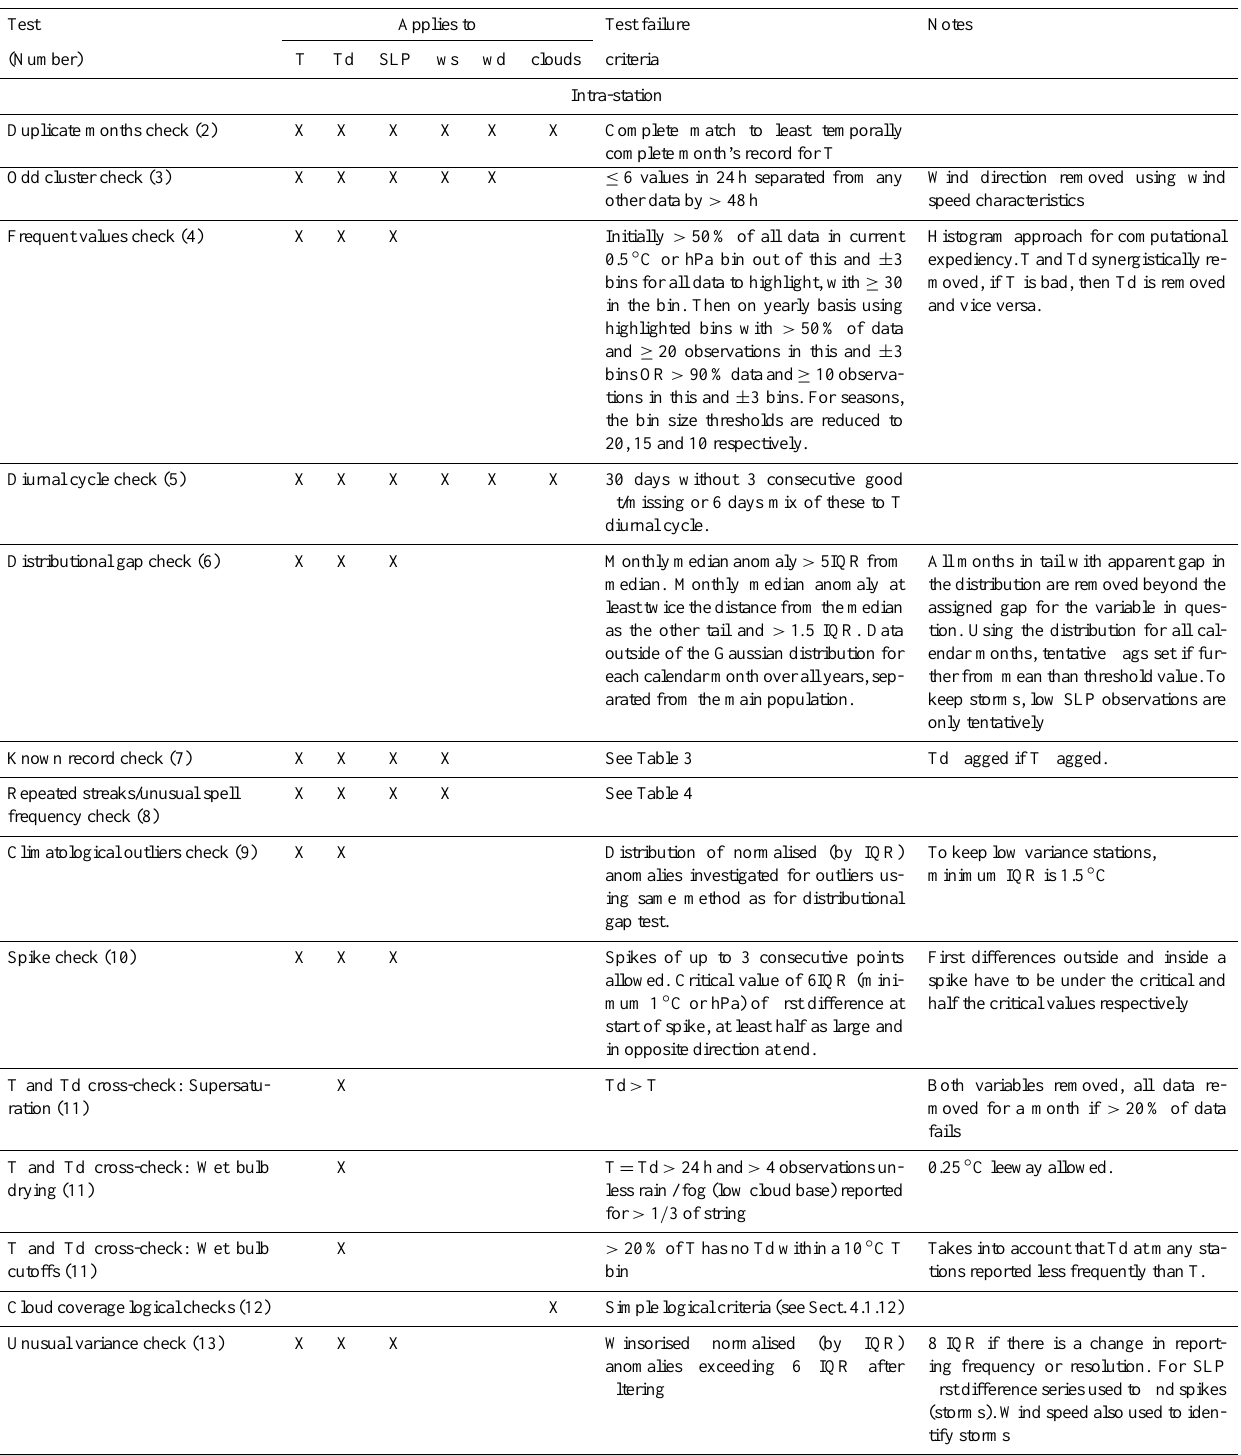
Table 5. Summary of tests applied to the